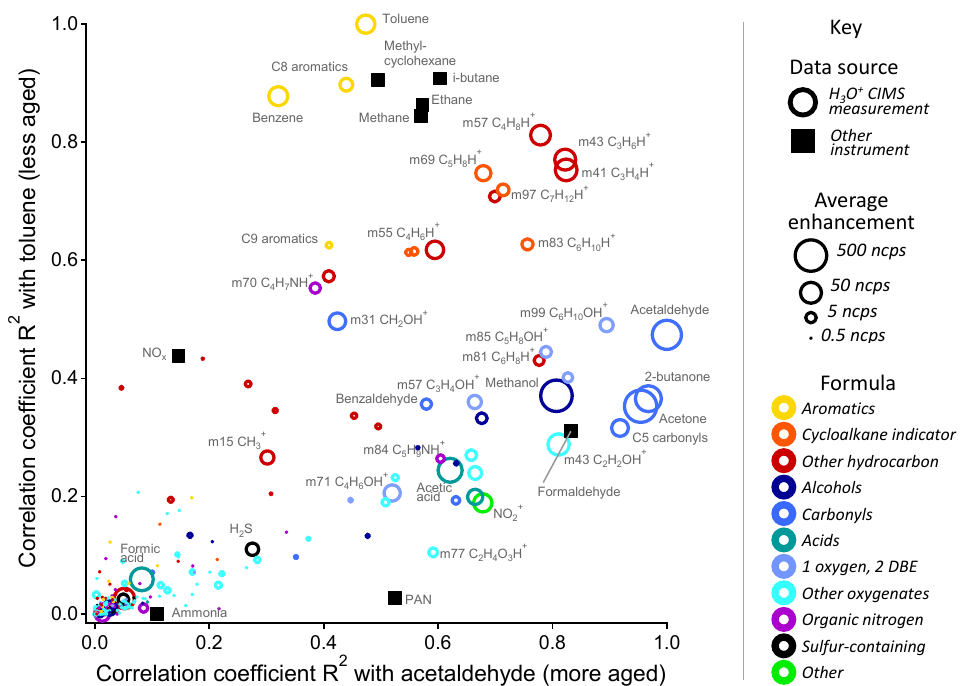
Figure 7. H 3 O + ToF-CIMS VOC ion mass correlation with toluene, representative of less aged emissions, and with acetaldehyde, repre- sentative of more aged emissions. Toluene and acetaldehyde were selected for this analysis because they have high signal-to-noise ratio and unambiguous VOC ion